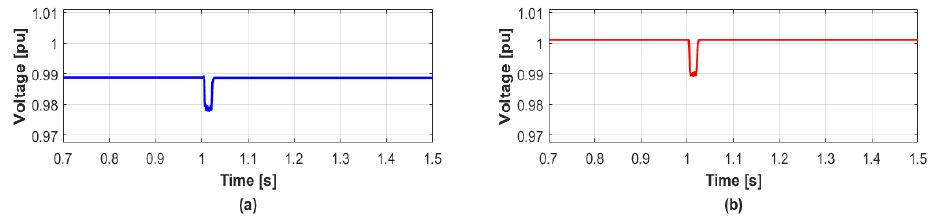
Figure 11. Voltage responses with the proposed method in Case 3. ( a ) Bus 2 ( b ) Bus 3. Table 7. Comparison of voltage variations in Case 3.